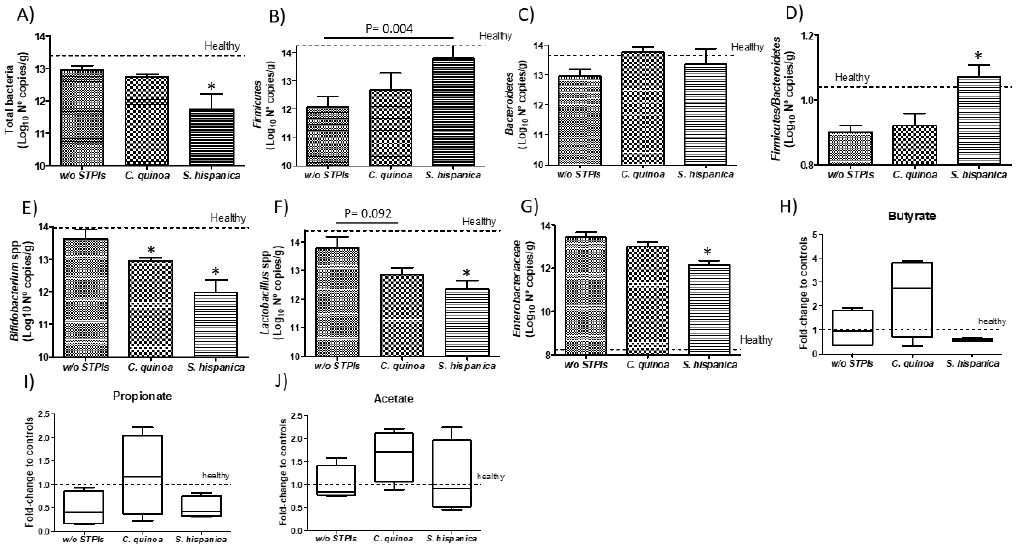
Figure 6. Colonic account of different bacterial phyla ( A – G ) of hepatocarcinoma developing mice administered with protease (serine-type) inhibitors (PIs). Relative variation of microbial metabolites ( H – J ). Results are expressed as mean ± SEM ( n = 4 − 6). * Indicates statistical differences (Dunn’s test, p < 0.05).